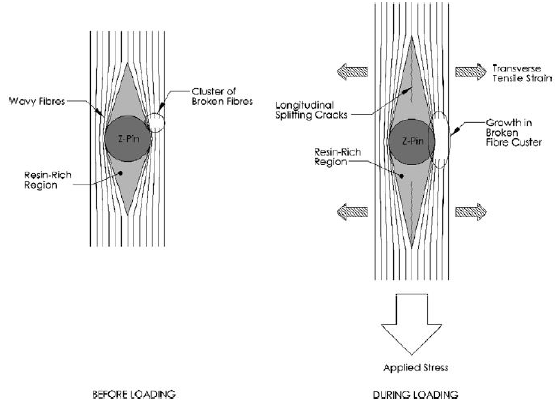
Figure 43. Schematic of the fatigue failure mechanism in z-Pinned 0 ◦ fiber direction ply [16].